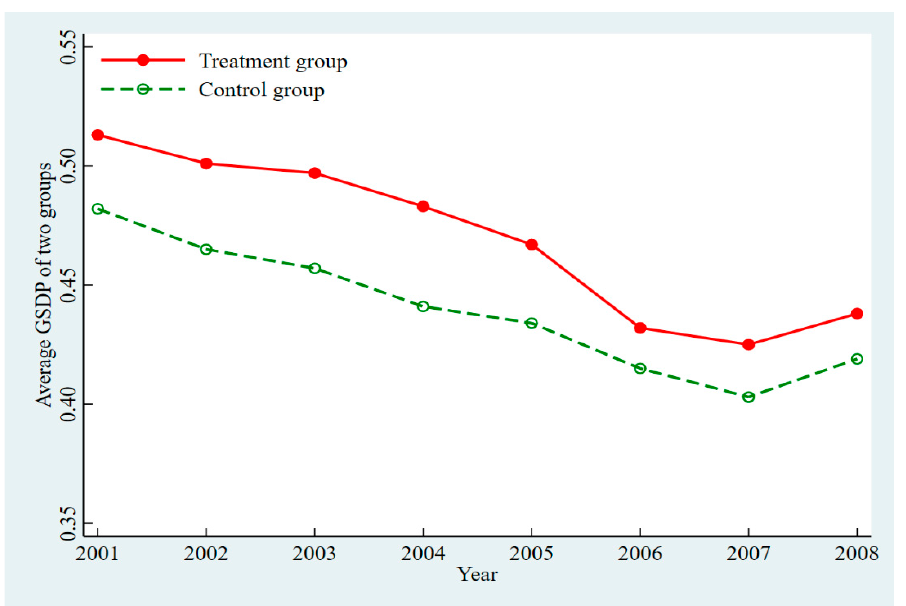
Figure 2. The average GSDP of the two groups in the Yangtze River Delta urban agglomeration from 2001 to 2008.